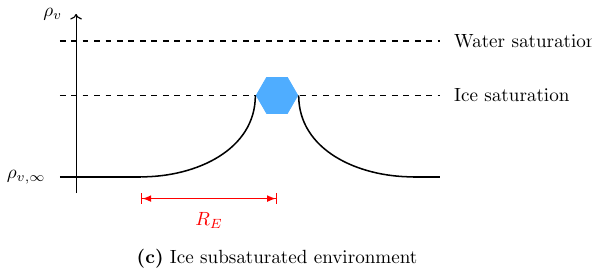
Figure 1. Schematic of the water vapor density field around an ice crystal with various environmental water vapor values ρ v , ∞ . Wa- ter vapor density at the ice crystal surface is assumed to equal the ice saturation density. In all cases, the ice crystal deforms the wa- ter vapor field locally within a ball of radius R E . If a droplet has a distance smaller than R E from the ice crystal, its growth behav- ior is determined by the local value of water density instead of the environmental value ρ v , ∞ .